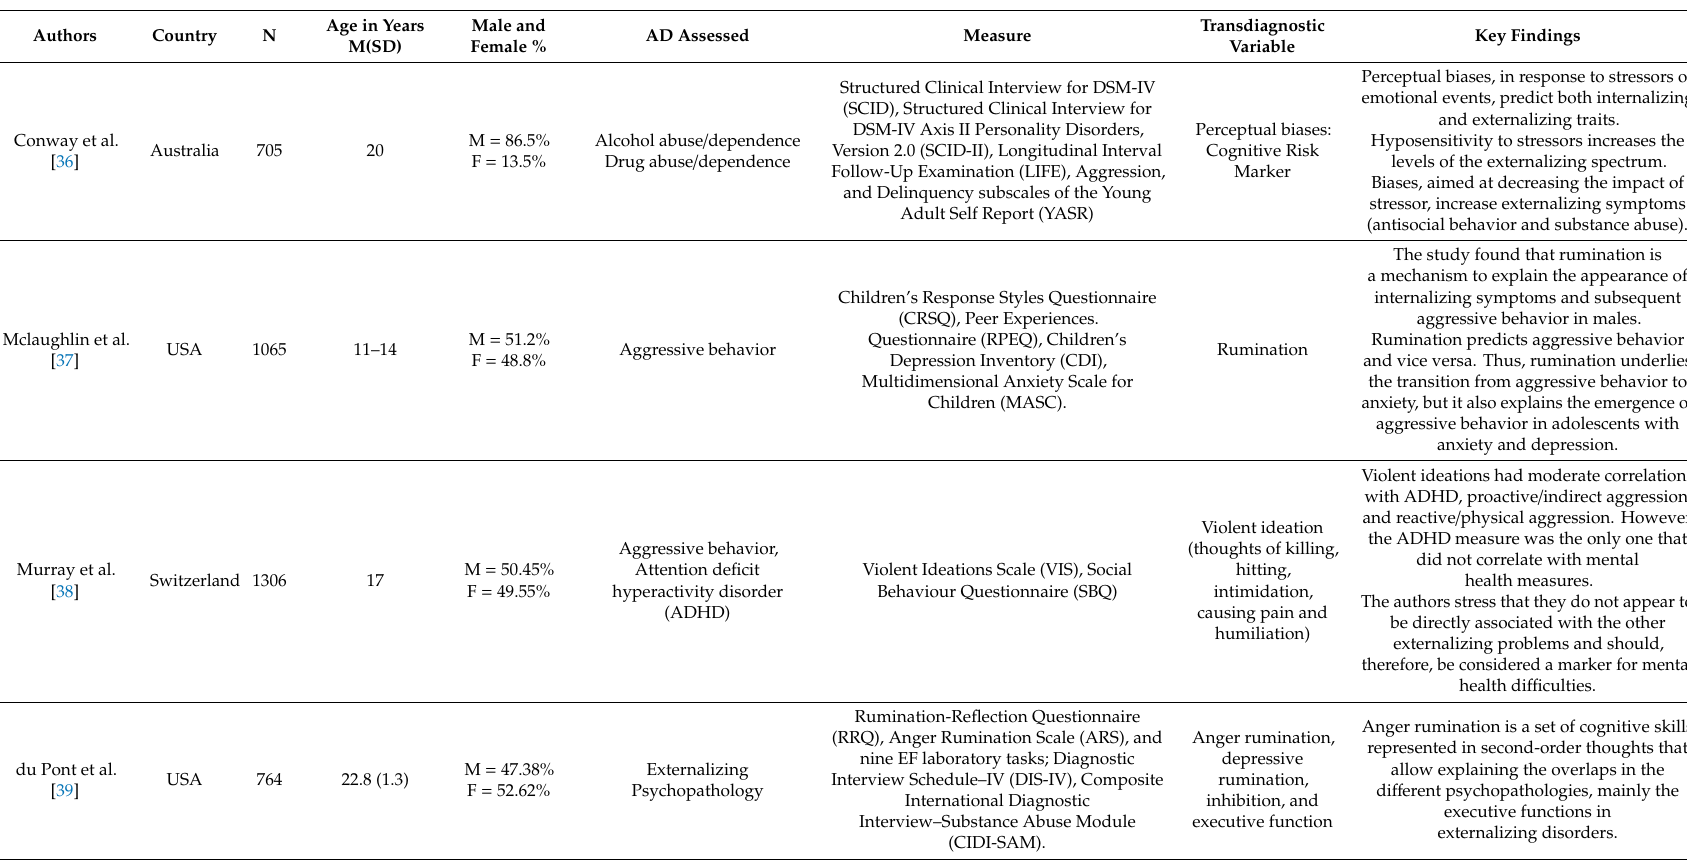
Table 4. Reviewed empirical studies including transdiagnostic variables in antisocial disorders at the cognitive